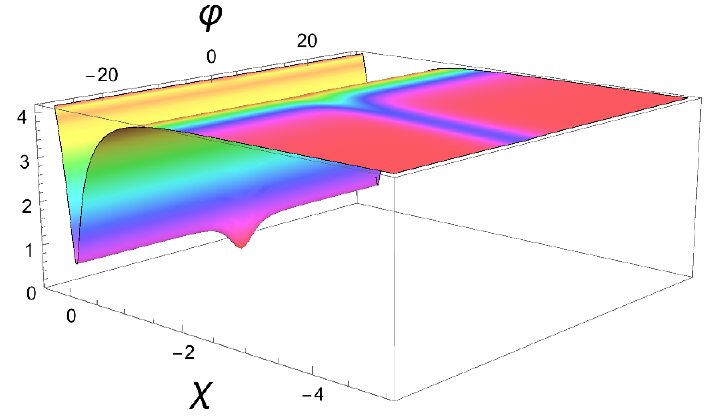
Figure 5 . Fibre in(cid:13)ation cascades. In(cid:13)ation begins at a high dS plateau with the height M 2 V 04 . 2 2 Then the (cid:12)elds fall to the narrow valley at (cid:31) = 1 p log V to its minimum at ’ = 1 p log V . In 0 0 8 8 6 3 order to simultaneously show the upper plateau, as well as the minimum of the potential shown in p (cid:12)gure 4, instead of V we plot here log(100 V + 1) for a particular case M = m = 0 : 1, V 0 = 2 2. The early stages of in(cid:13)ation in this model are described by the cascade in(cid:13)ation scenario described in [8]. In(cid:13)ation may begin at the upper plateau. Depending on the position on the plateau, the (cid:12)elds either directly moves to smaller values of (cid:31) , or (cid:12)rst moves towards p the blue valley at ’ = 2 (cid:31) (i.e, at (cid:30) = 0), and then moves down along this valley. The 2 process (cid:12)nishes by the second stage of in(cid:13)ation along the deep valley with (cid:31) = 2 p log V 0 8 6 shown in (cid:12)gure 4, corresponding to the T-model with (cid:11) =